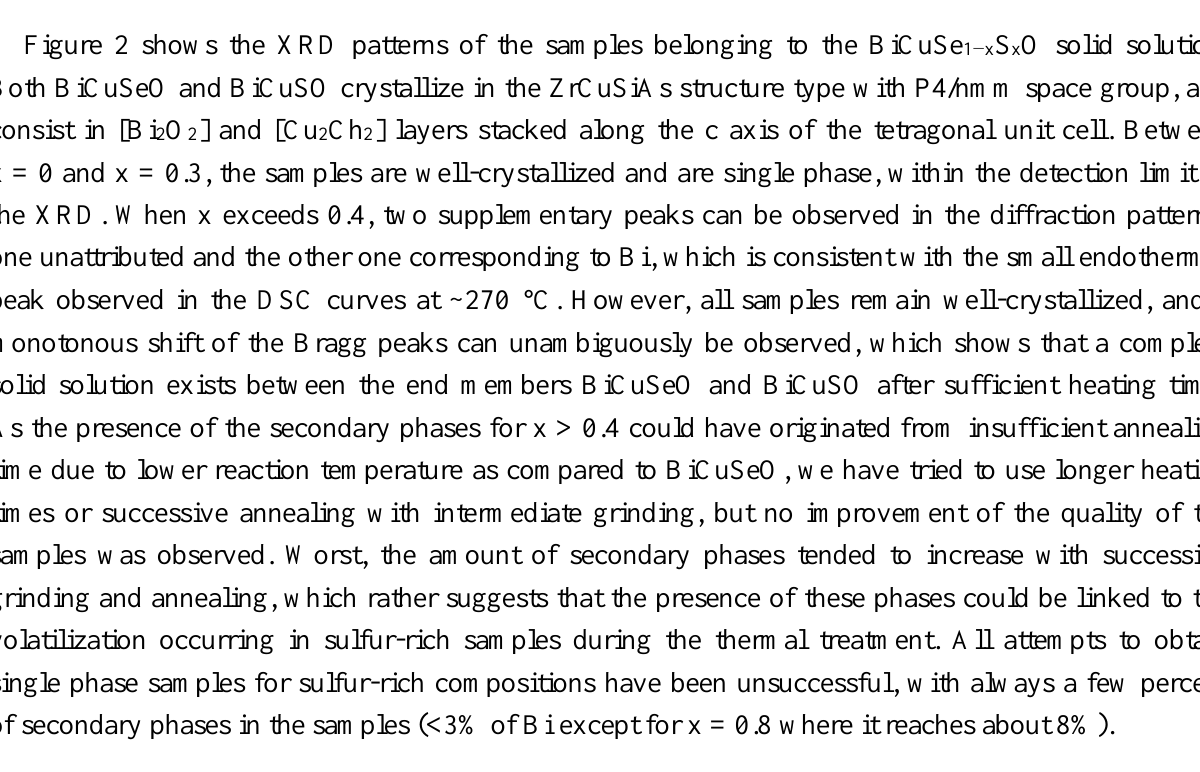
Figure 1. Differential scanning calorimetry curves of BiCuSe 1−x S x O powders under argon ( a ) and thermogravimetric analysis of BiCuSe 1−x S x O powders under argon ( b ). The peak marked with a * in the DSC curves corresponds to the melting of Bi. The inset shows the onset of the DSC peak corresponding to the decomposition of BiCuSe 1−x S x O and the onset of weight